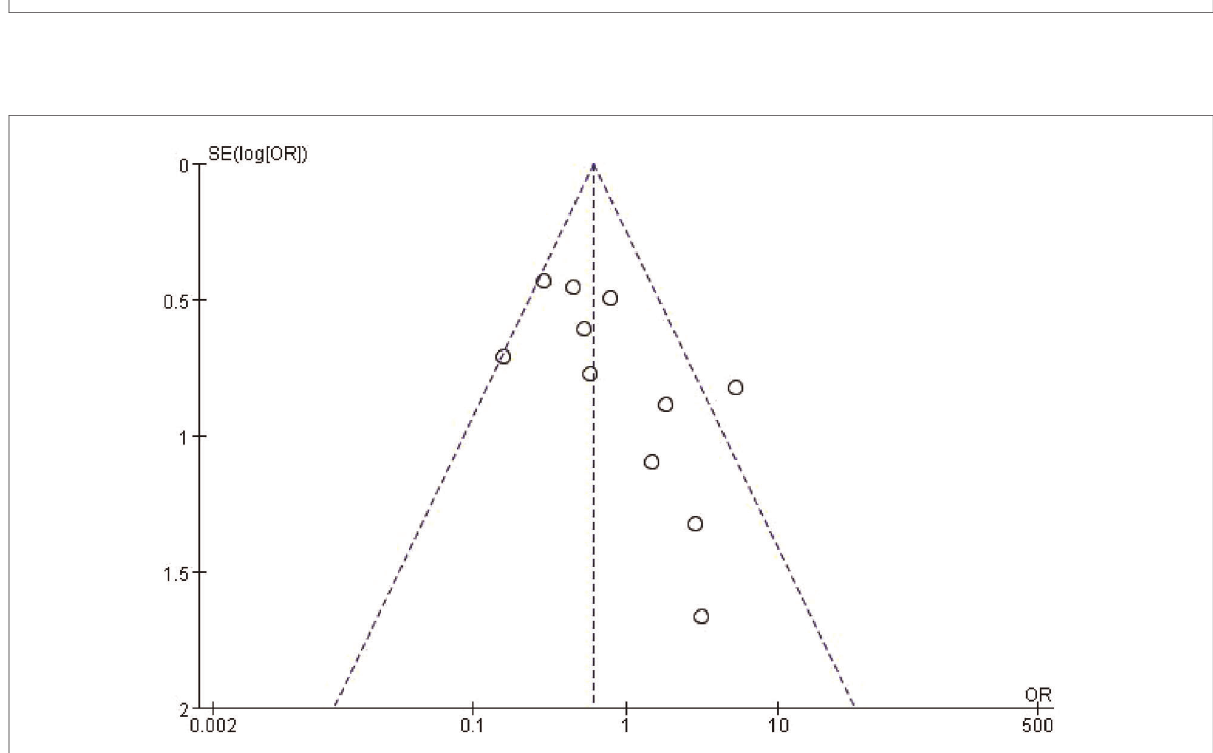
FIGURE 8 Plot of the fi nal fusion